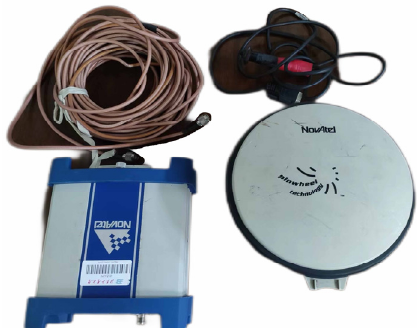
Figure 4. Vehicle equipment used in the experiment: Dynamic GPS.